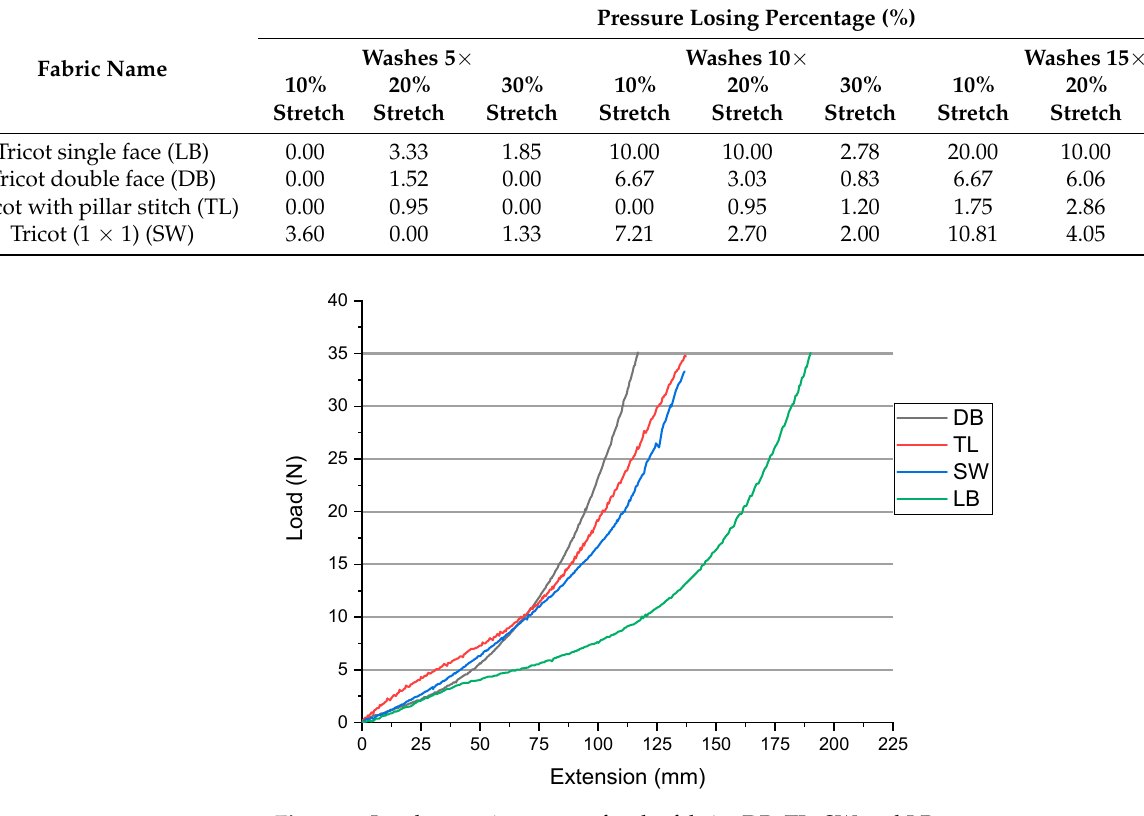
Figure 5. Load-extension curves for the fabrics DB, TL, SW and LB.